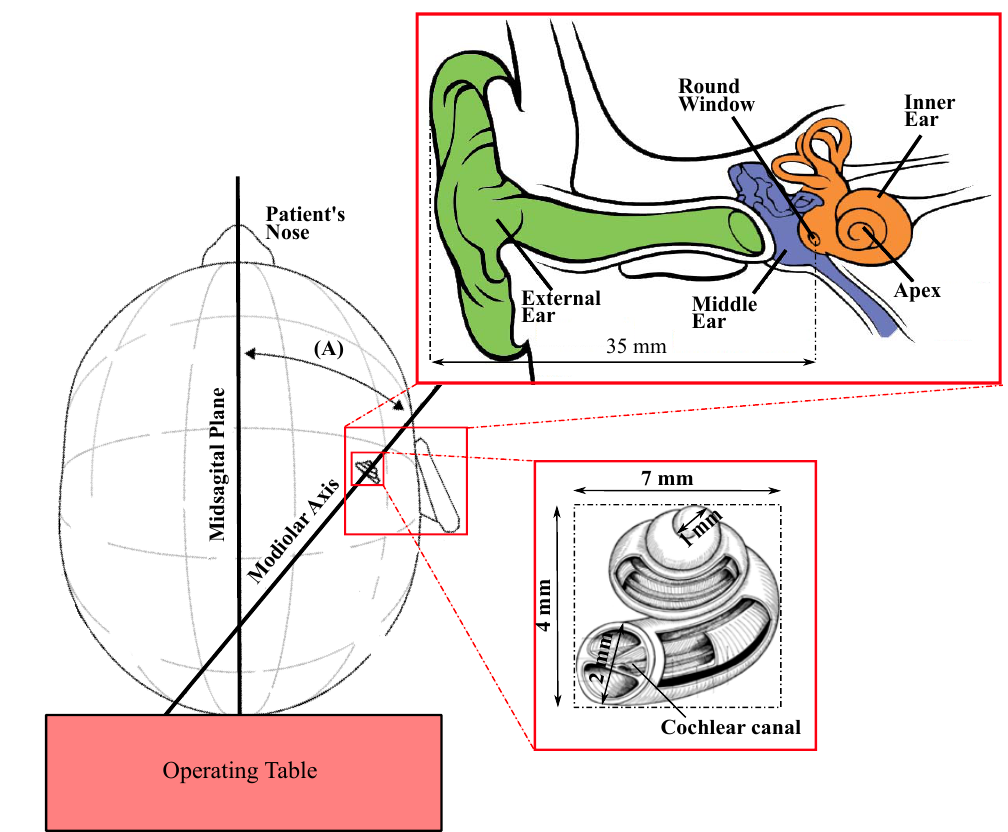
Figure 1. Position, orientation (A), and approximate dimensions of the cochlea